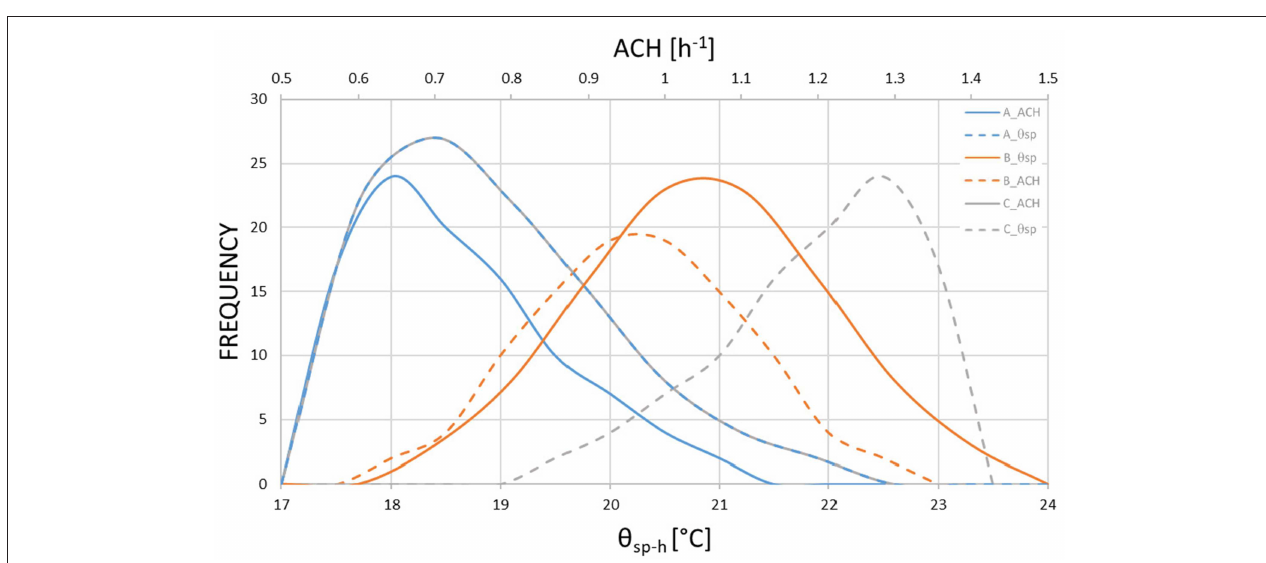
FIGURE 8 | Selected distributions of input variables θ sp − h and ACH toward computation of annual heating demand (see Figure 7 ). Reproduced from Berger et al. (2020) with permission from C. Berger, E. Primo, D. Wolosiuk, V. Corrado, and A. Mahdavi.